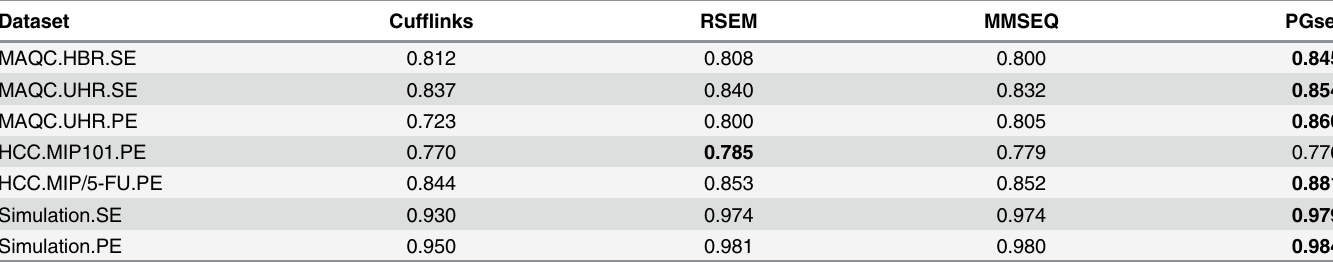
Fig 4. Transcript expression deconvolution by PGseq for gene ENSG00000152291. (a) and (b) show the normalized read counts for samples HBR and UHR, respectively, for each exon. (c) shows the estimated gene-specific bias distribution. The 3rd panel shows the obtained NB distributions for both gene and isoforms for the two samples. The last panel presents the approximated Gaussian distributions of logged gene and isoform expression. This gene contains six isoforms and the total normalized read counts for the two samples are both 1321. doi:10.1371/journal.pone.0140032.g004 Table 1. Comparison of expression estimation accuracy at gene level using various